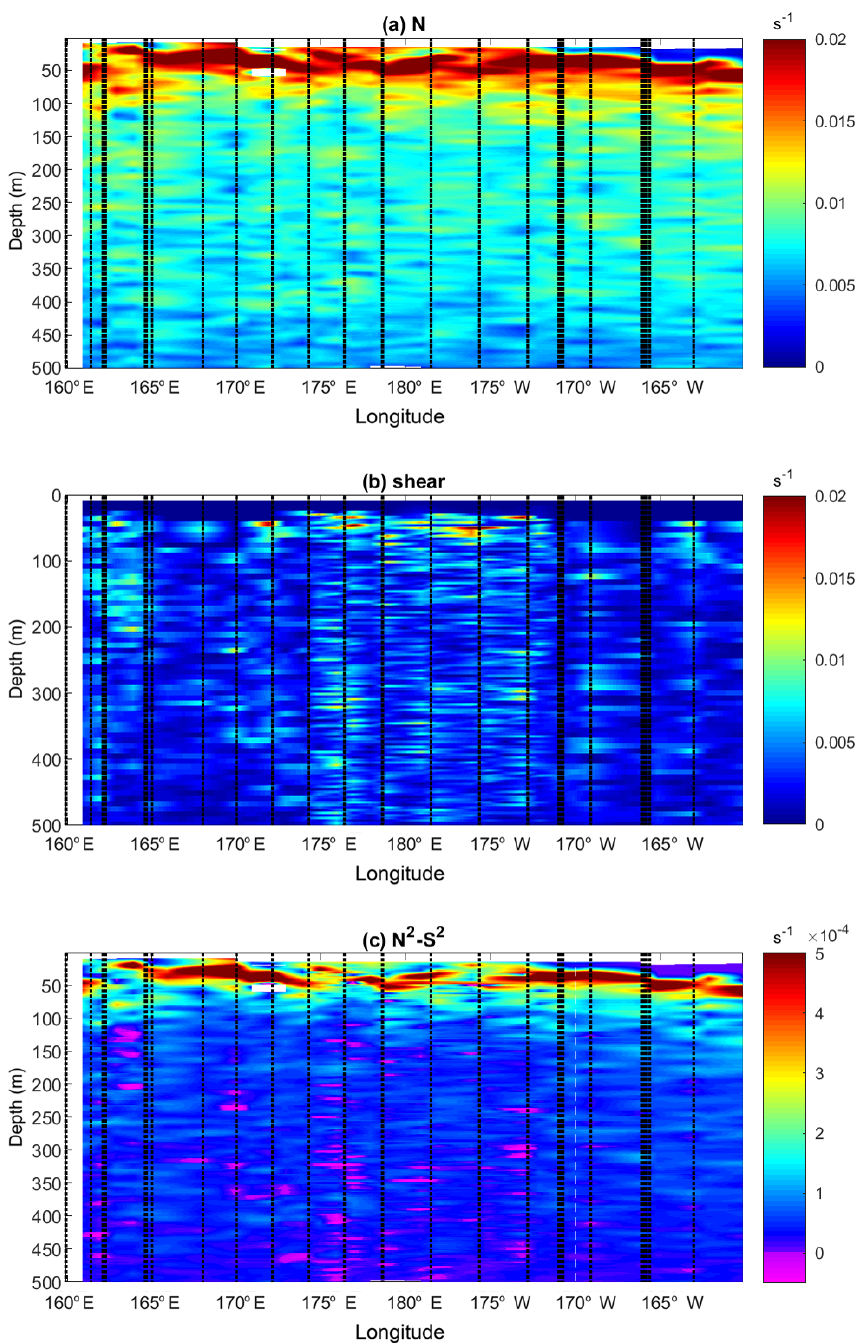
Figure 4. Buoyancy frequency, N (a) , shear, S (b) , and N 2 − S 2 (c) as a function of longitude and depth. The locations of the CTD and LADCP profiles are displayed with black dashed lines. S is inferred from LADCP data and N was vertically averaged over 8m length vertical intervals for consistency with the 8m bin of the LADCP